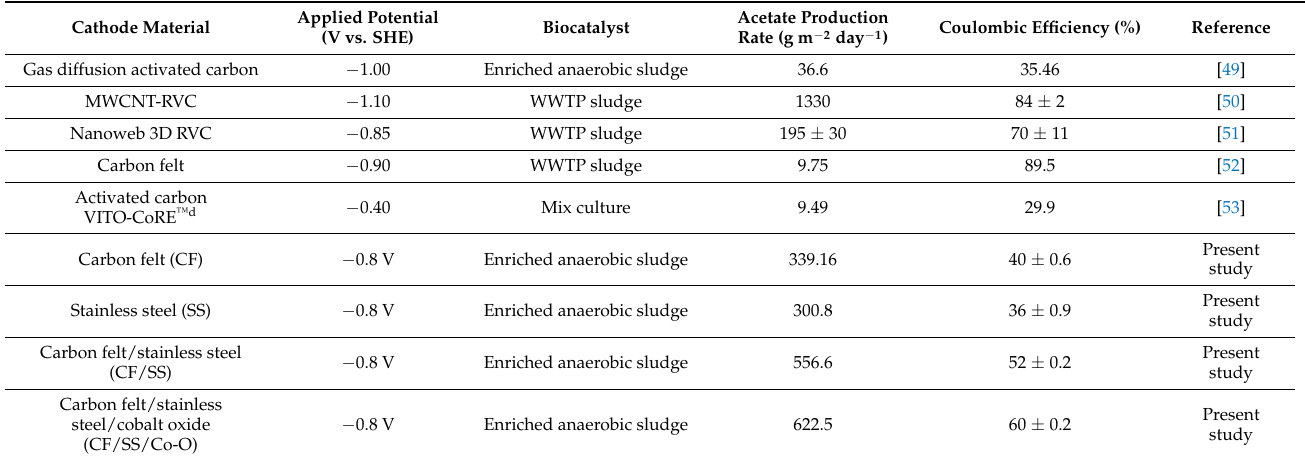
Table 1. Comparison of results with other microbial electrosynthesis investigations.